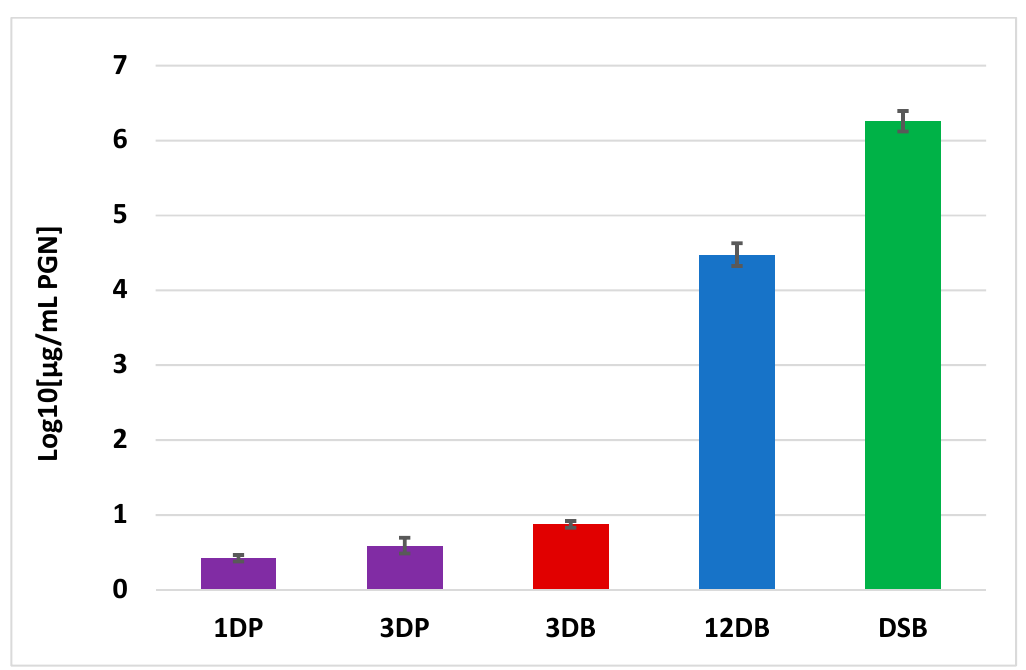
Figure 5. Peptidoglycan concentration of number S. aureus cells grown in planktonic and biofilm mode. [Bars of different colour are significantly different from each other ( p < 0.05)].